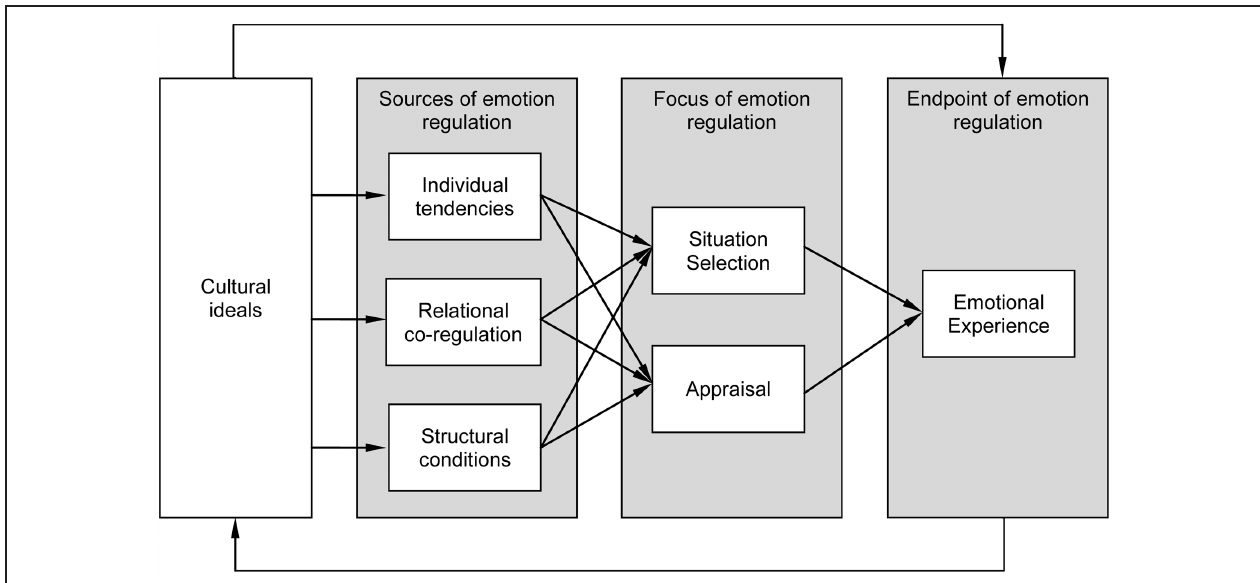
FIGURE 1 | Three sources of antecedent-focused emotion regulation in cultural context.